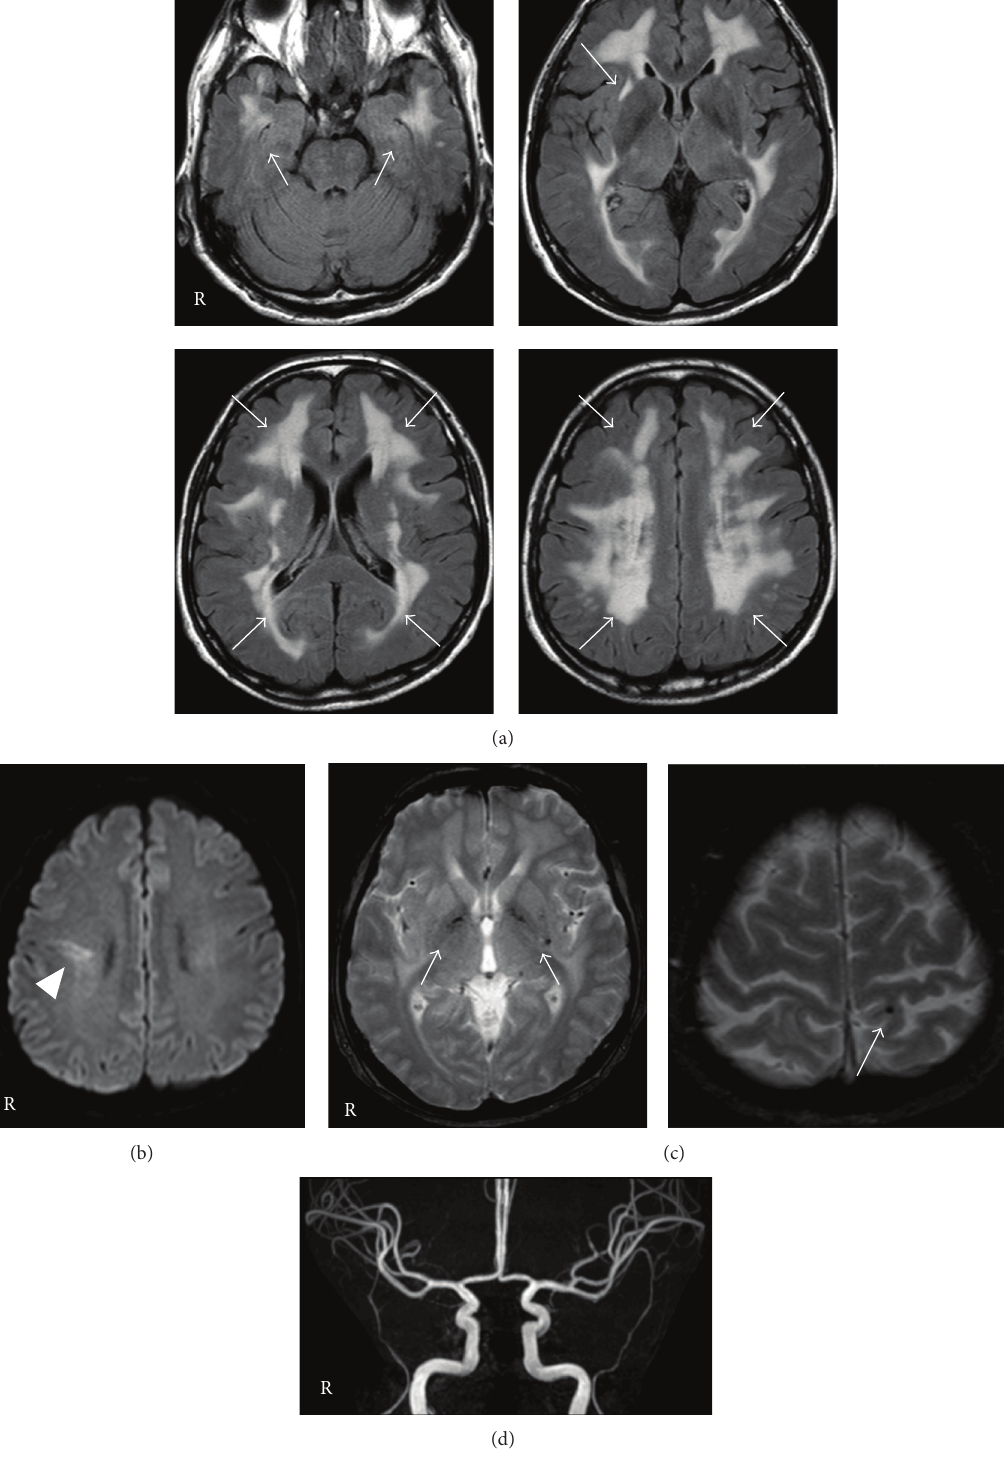
Figure 1: Magnetic resonance images and magnetic resonance angiograms. (a) Fluid attenuated inversion recovery (FLAIR) images demonstrated diffuse hyperintensities in the periventricular and subcortical white matter involving both temporal pole regions and the external capsule (arrow). (b) A hyperintense area on diffusion-weighted images (arrowhead). (c) T2 ∗ -weighted images showed multiple microbleeds (arrow). (d) Magnetic resonance